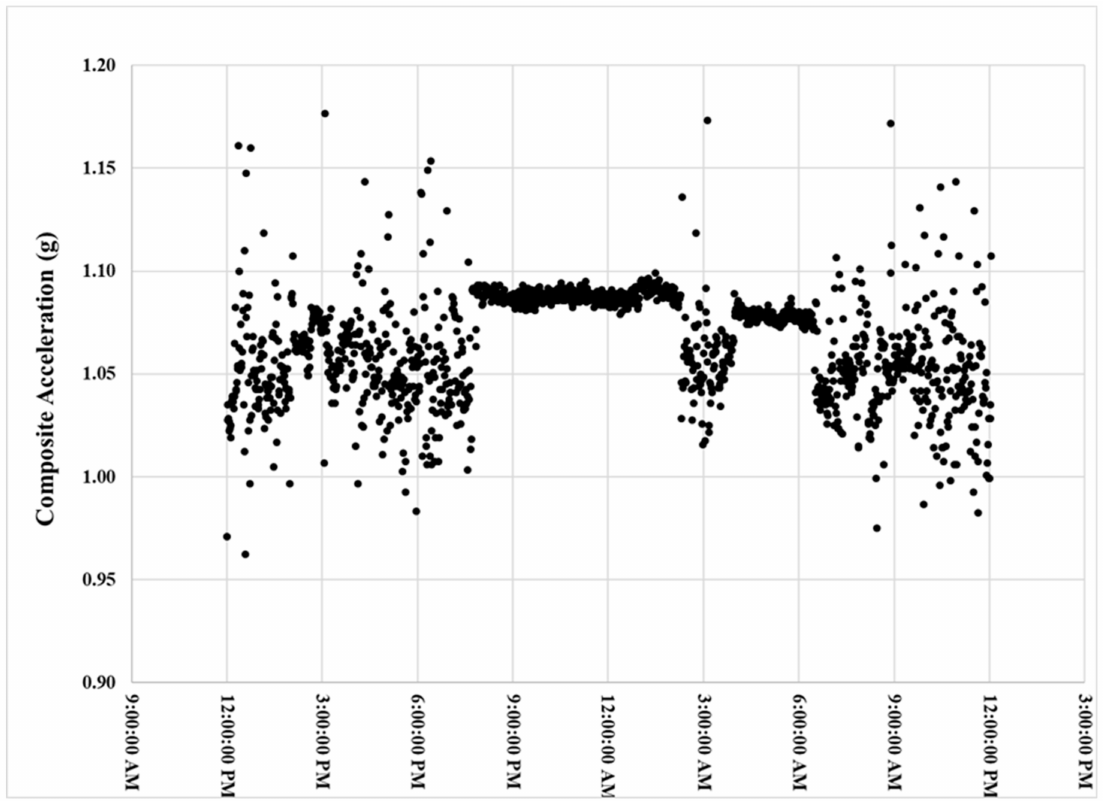
Figure 3. MicroPEM composite acceleration time series that illustrates the participant’s activity level and 89% compliance wearing the device according to the study